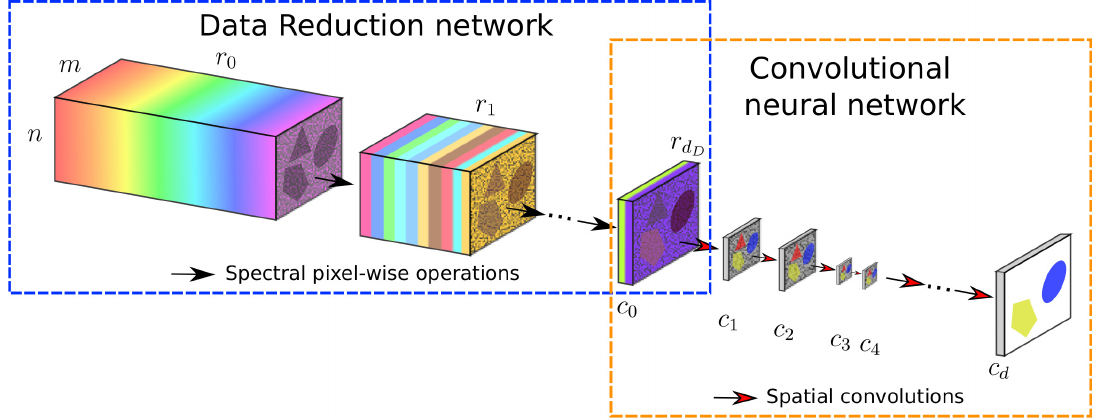
Figure 3. Schematic structure of a Data Reduction CNN example. The entire setup consists of a CNN of choice, for example with down- and upscaling layers as shown here, and a data reduction subnetwork in front. This subnetwork repeatedly decreases the number of images from r 0 down to r d linear combinations of the input images. After that, the CNN carries out the segmentation